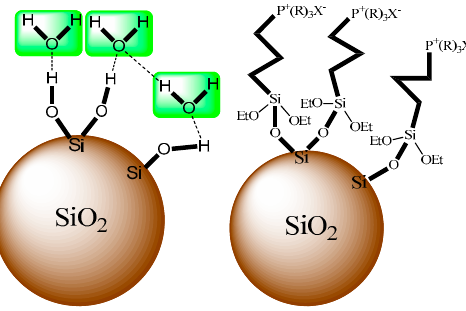
Figure 7. Schematic diagram of the ionic liquid membrane on the surface of the carrier.